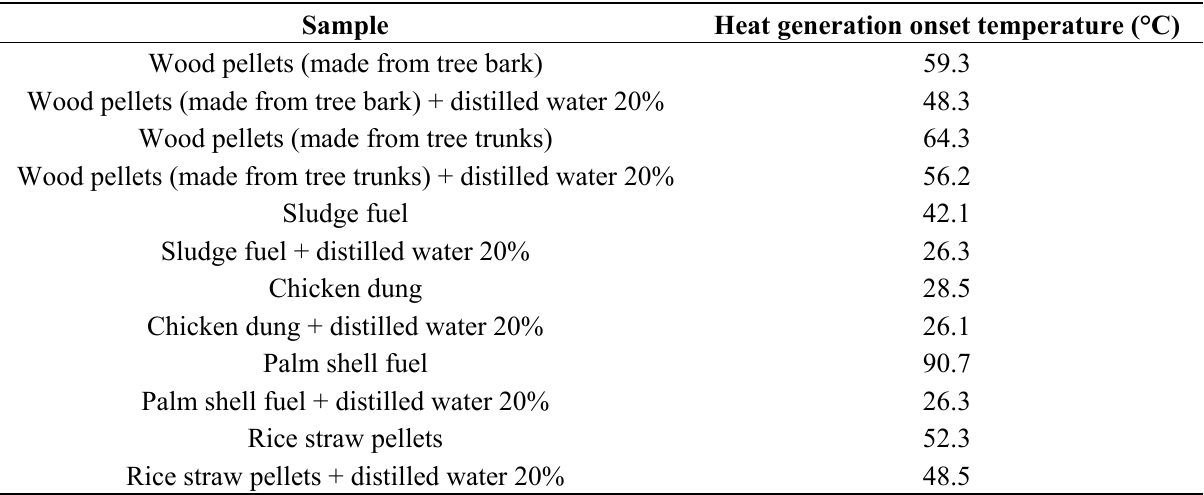
Table 1. Heat-generation onset temperatures of various biomass fuels, as determined by C80